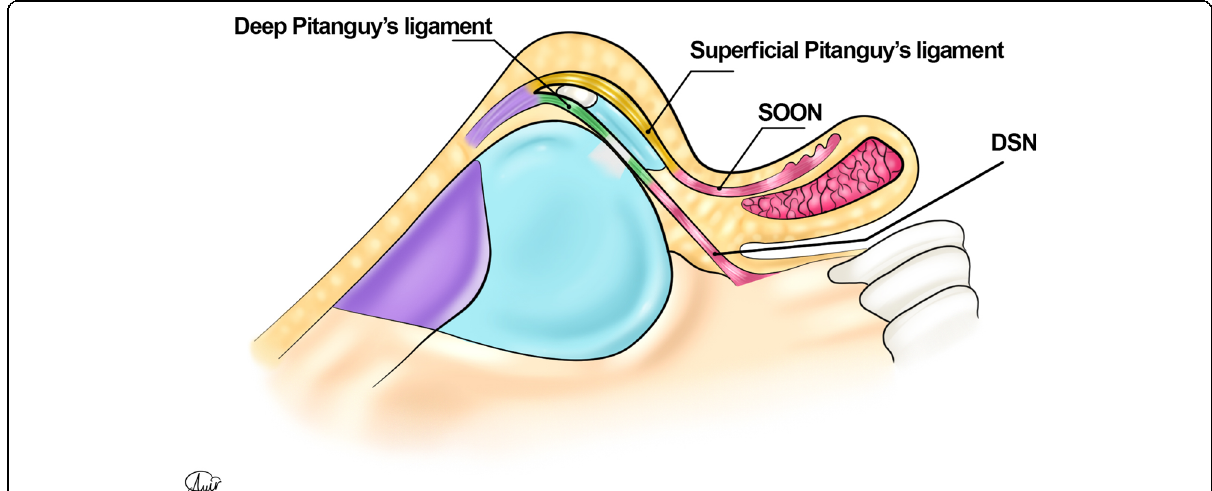
Fig. 15 Superficial and deep pitanguy ligaments continue caudally as the superficial orbicularis oris nasalis (SOON) and depressor septi nasalis (DSN) muscles